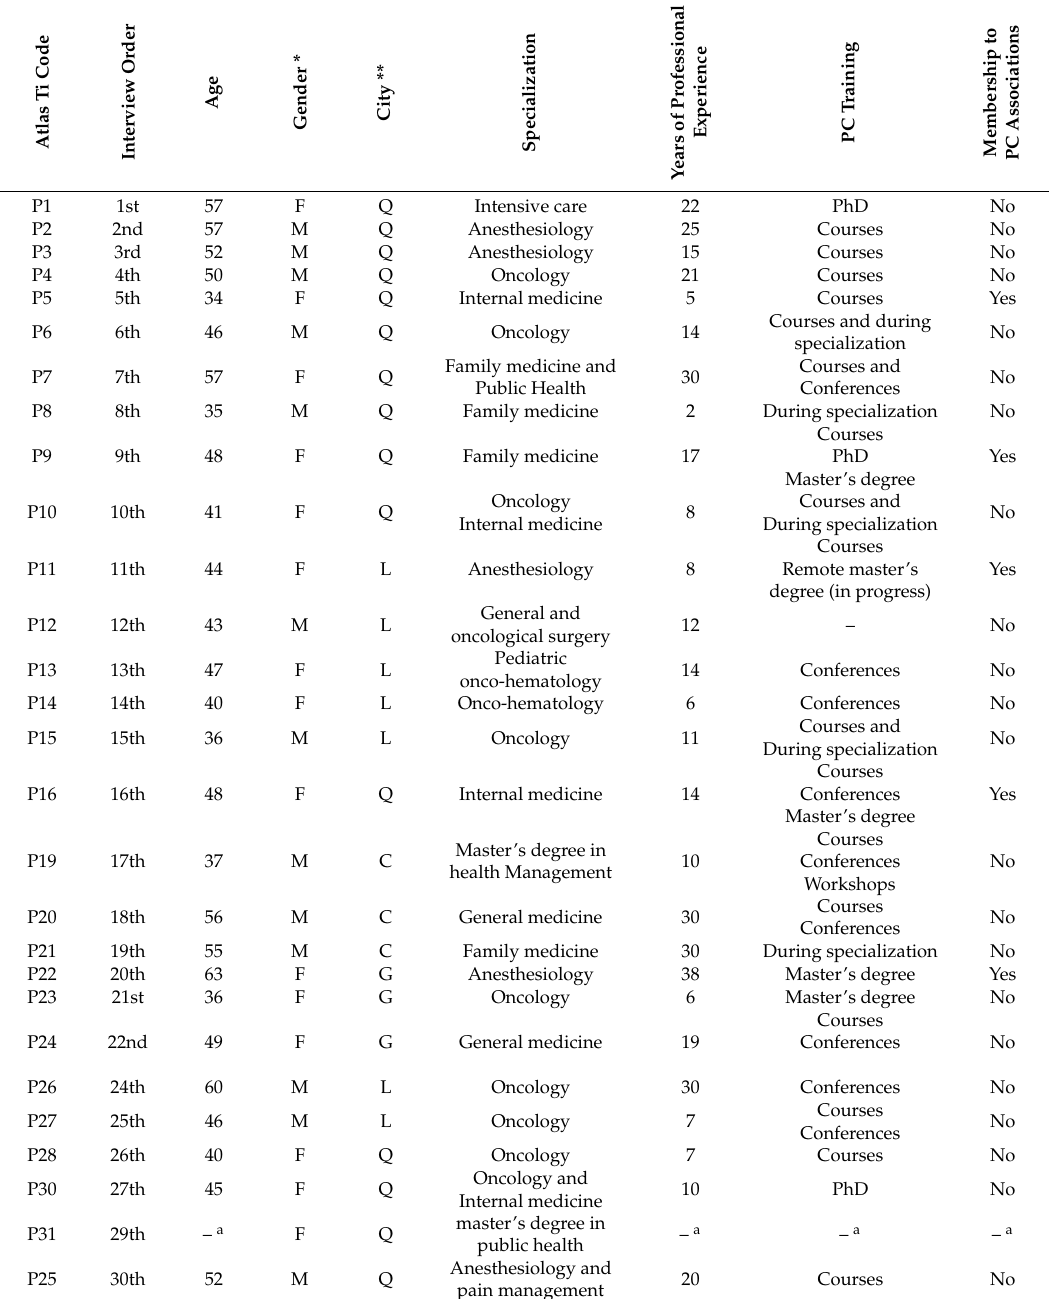
Table 2. Sociodemographic data of the